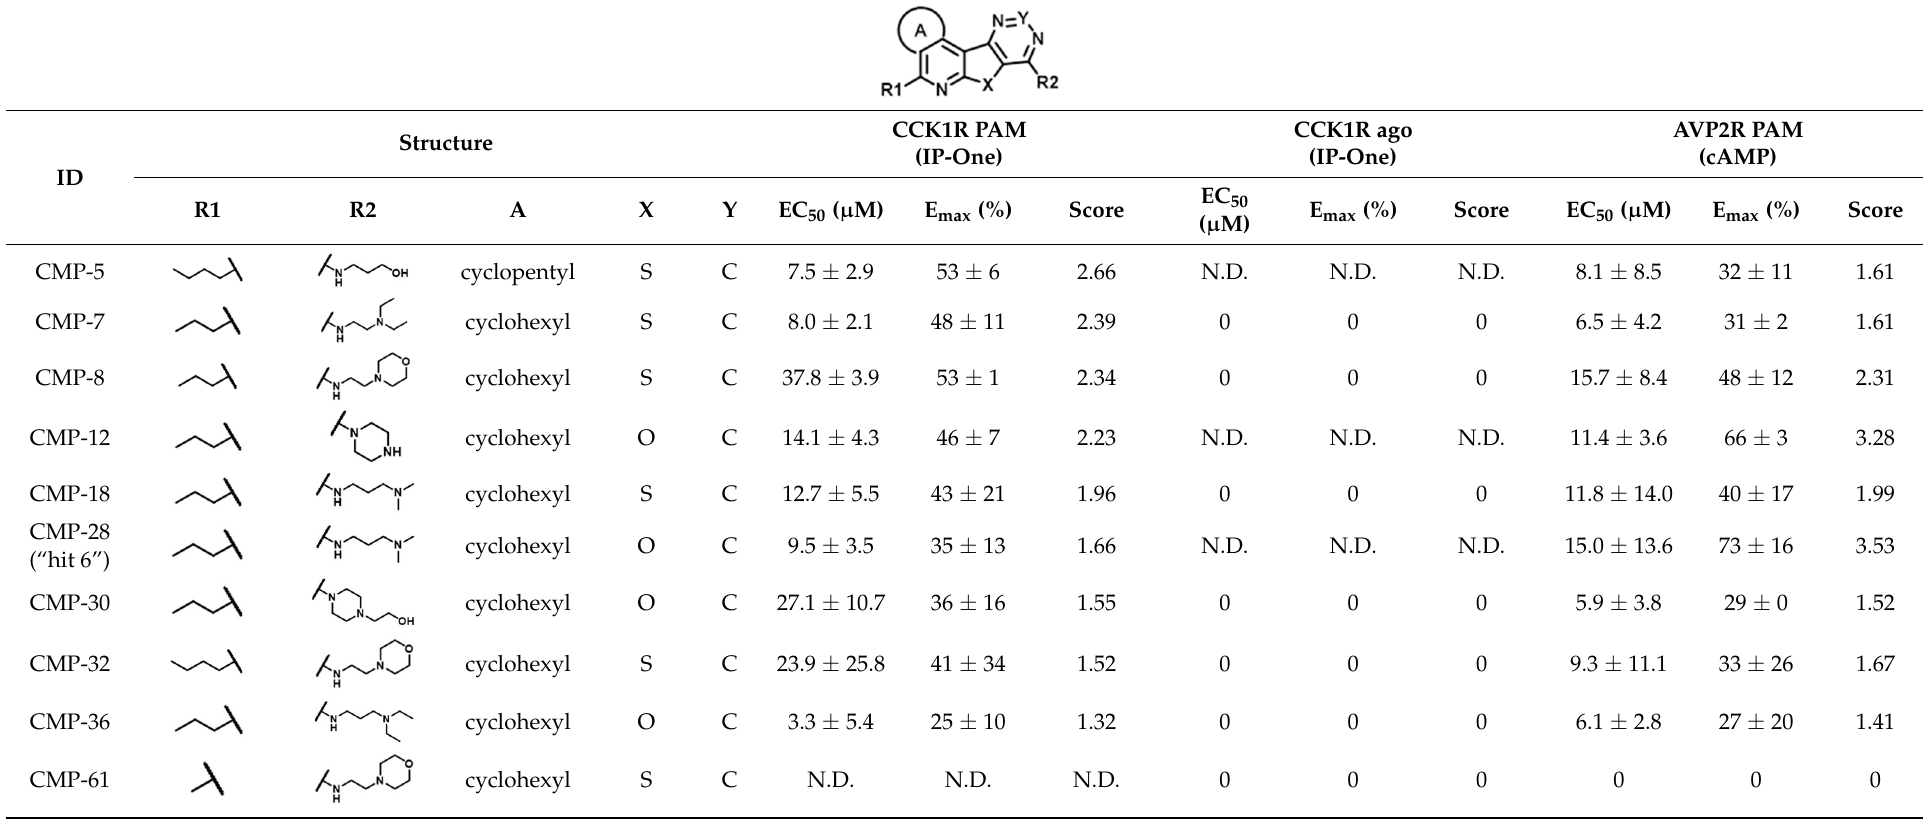
Average potencies (EC 50 (µM) ± standard deviation (SD)), average compound efficacy (E max (%) ± SD), and calculated activity score (E max × pEC 50 ) of compound dose–response studies in screening mode. Compounds were tested in Cisbio IP-One and cAMP accumulation assays; N.D. = not determinable (response less than mean ± 3 × SD of negative control). Table 7. Structure–activity studies of 10 branched alkyl analogs. Table 6. Structure–activity studies of 10 n -alkyl analogs.